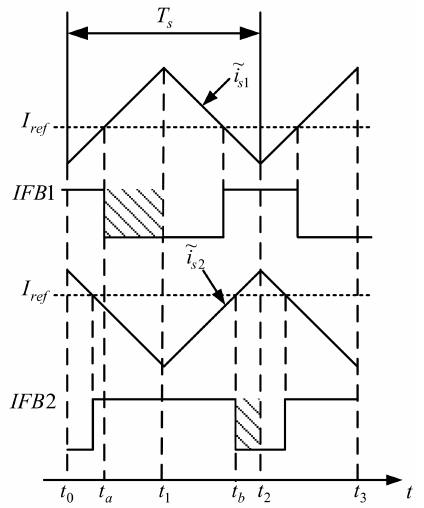
Figure 17. Interleaved current sampling.